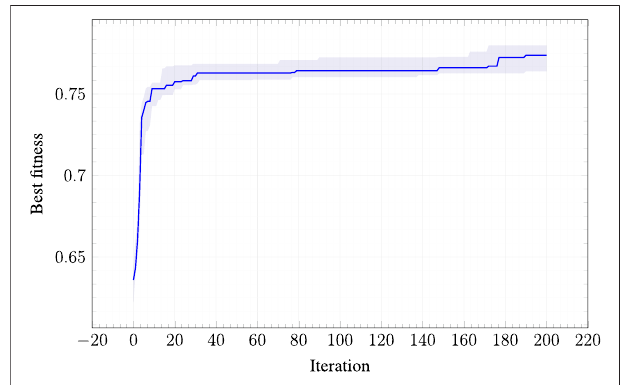
FIGURE 4 | Criticality of the best morphology at each iteration of the EA used for optimizing the morphologies. The solid lines indicates the median across the 10 runs; the shaded area corresponds to the interquartile range (from 25-th to